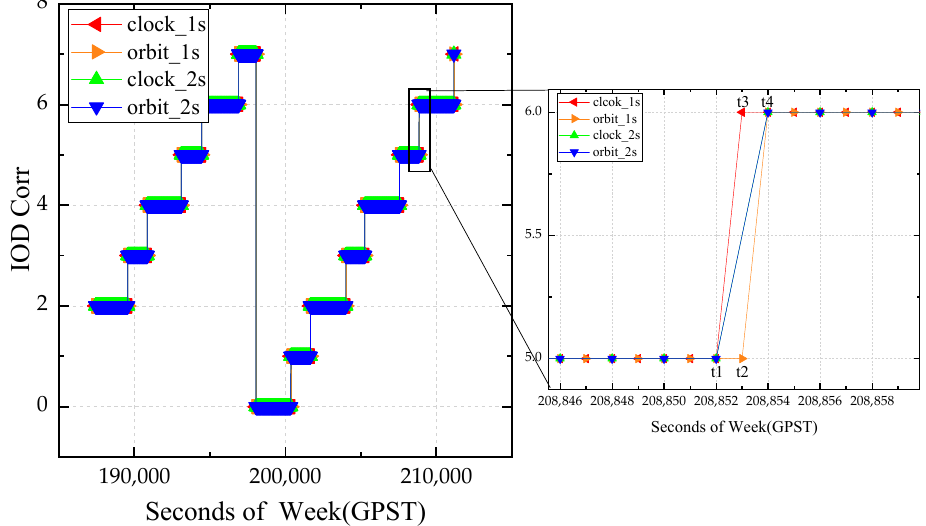
Figure 2. Take time a as reference to update IOD Corr (C23, 8 March 2022).